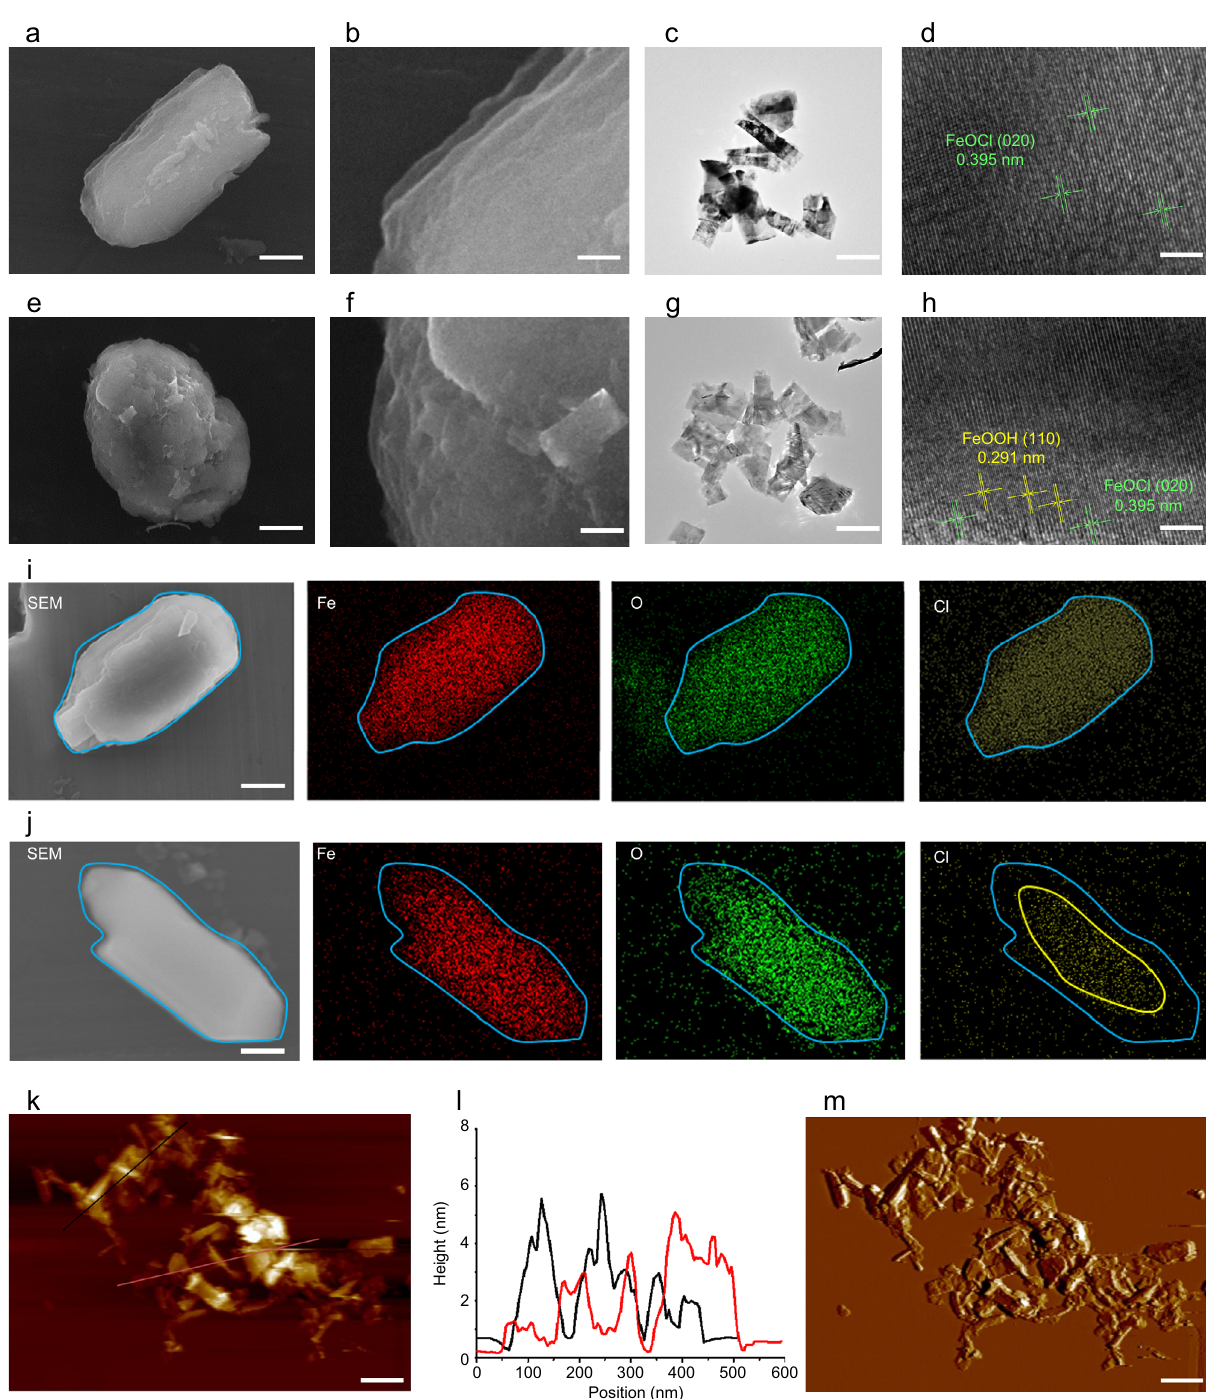
Fig. 2 Morphology and composition characterization of layered FeOCl NSs and FeOCl/FeOOH NSs. SEM images of layered a FeOCl and e FeOCl/ FeOOH, scale bar = 100 nm. Enlarged SEM images of layered b FeOCl and f FeOCl/FeOOH, scale bar = 15 nm. TEM images of ultrathin c FeOCl NSs and g FeOCl/FeOOH NSs, scale bar = 100 nm. HRTEM images of ultrathin d FeOCl NSs and h FeOCl/FeOOH NSs, scale bar = 3 nm. SEM-EDS mapping of i FeOCl and j FeOCl/FeOOH: red (Fe), green (O), and yellow (Cl), scale bar = 100 nm. k AFM images of FeOCl/FeOOH NSs, scale bar = 100 nm. l Thickness of FeOCl/FeOOH NSs. m 3D AFM images of FeOCl/FeOOH NSs, scale bar = 100 nm. For these morphology characterizations of fabricated FeOCl NSs and FeOCl/FeOOH NSs, three times each experiment was repeated independently with similar results. The units (arb. units) of intensities of XPS, XRD, and Raman spectra mean arbitrary units. Source data are provided as a Source Data fi